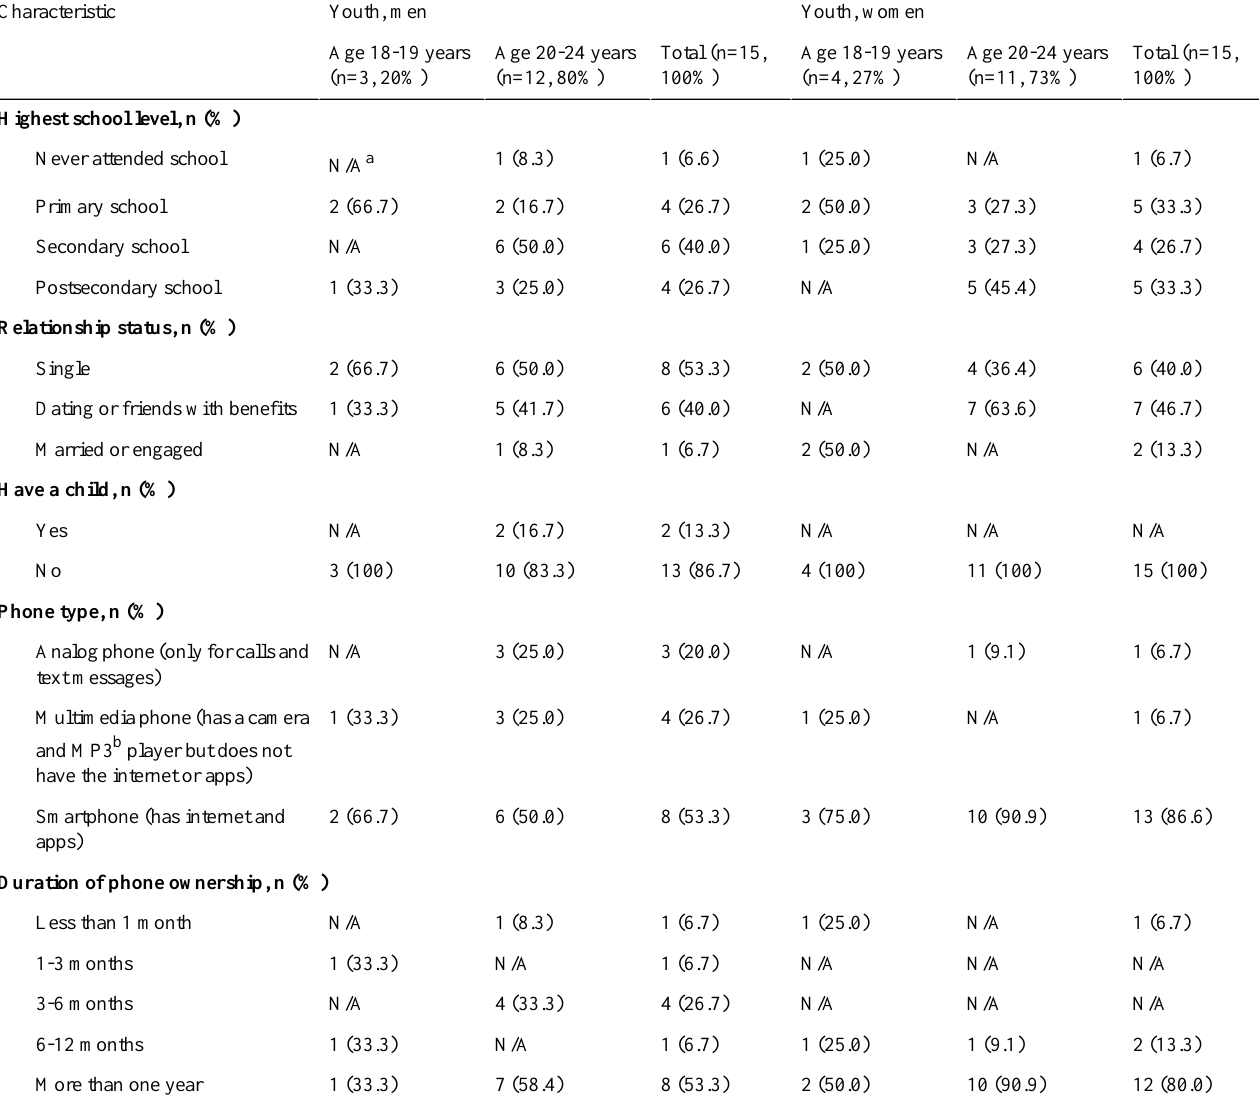
Table 1. Sociodemographic characteristics of study participants by sex (N=30).